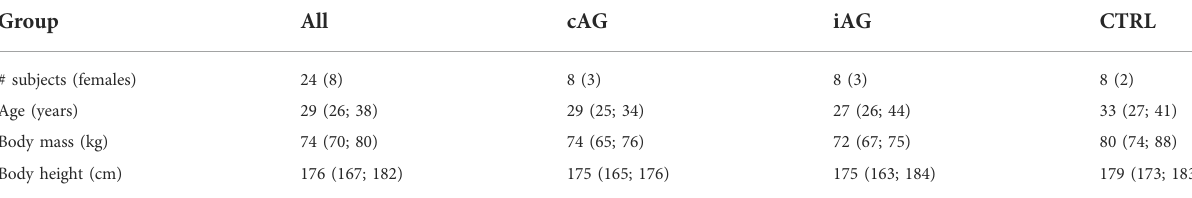
TABLE1DemographicsofthesubjectsenrolledintheAGBRESAstudyatbaseline(BDC-9).Dataarepresentedasmedian( fi rstquartile;thirdquartile), except for thenumber ofsubjects (numberof females in parentheses).cAG: continuous arti fi cial gravity;iAG:intermittentarti fi cial gravity; CTRL: